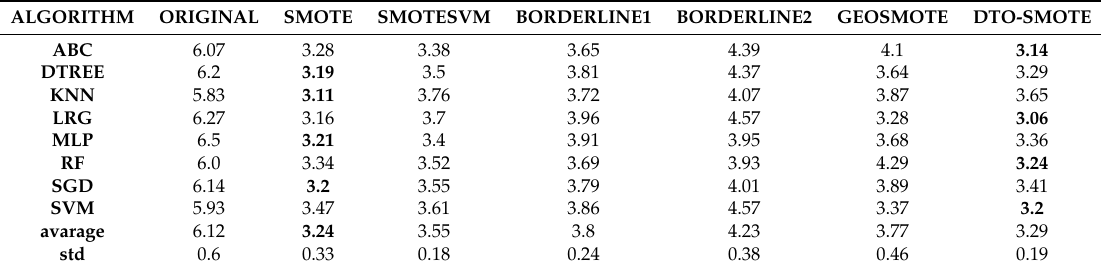
Table 8. Index of Balanced Accuracy (IBA) rank (solid angle and α = 7.0); see Table